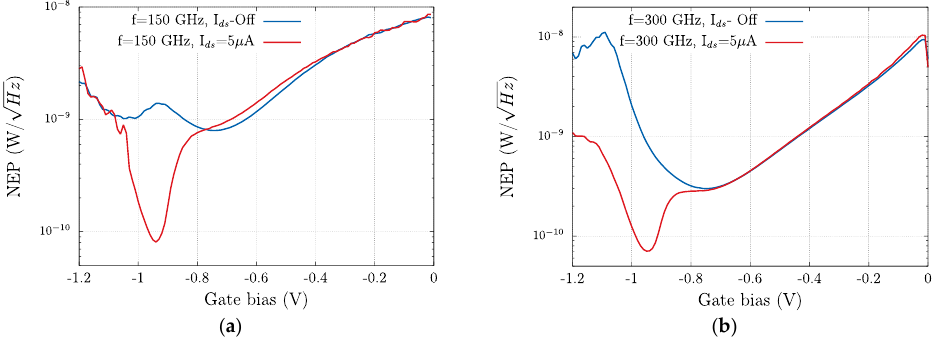
Figure 10. ( a ) NEP of the strained-Si MODFET from measurements under an excitation of 150 GHz in the photovoltaic mode ( I ds off) and for a bias source-to-drain current I ds = 5 μA; ( b ) same as ( a ) under an excitation of 300 GHz.